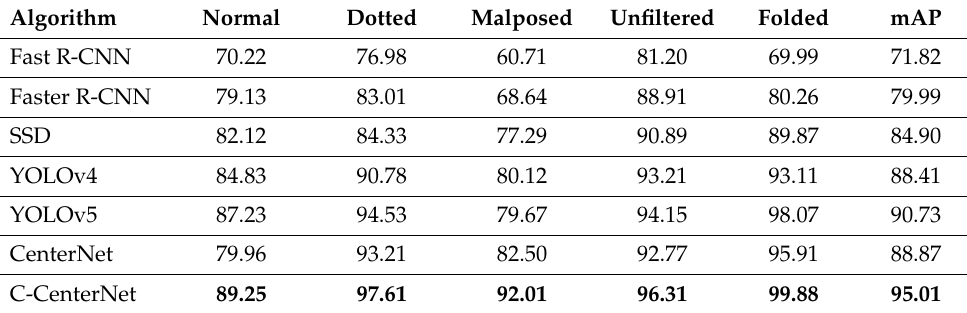
Table 3. AP comparison of various algorithms on various types of datasets